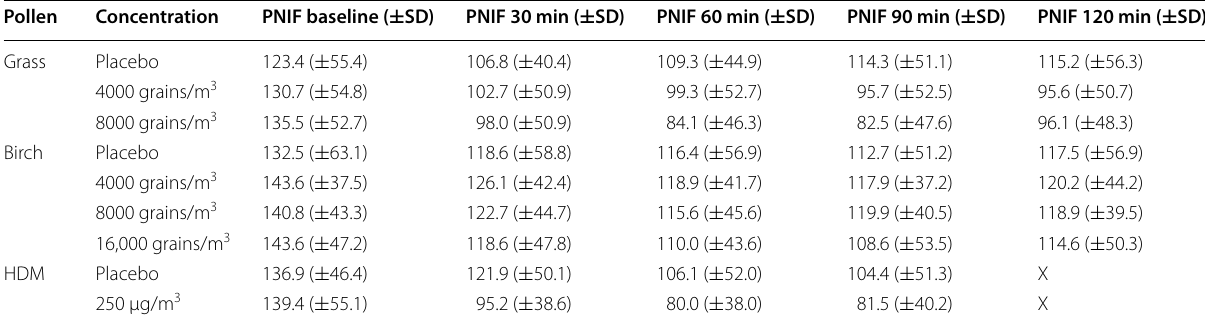
PNIF peak nasal inspiratory flow, SD standard deviation